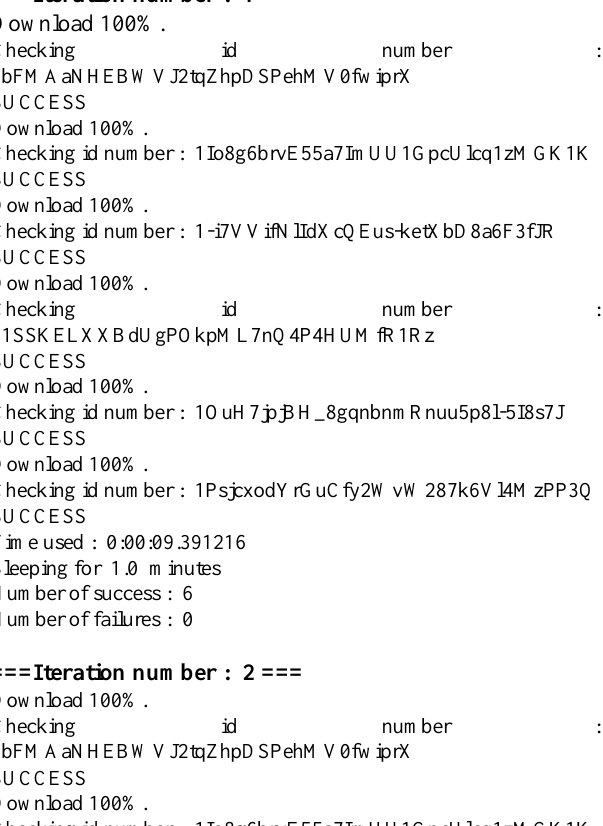
Table 1. Time taken during each iteration of monitoring process